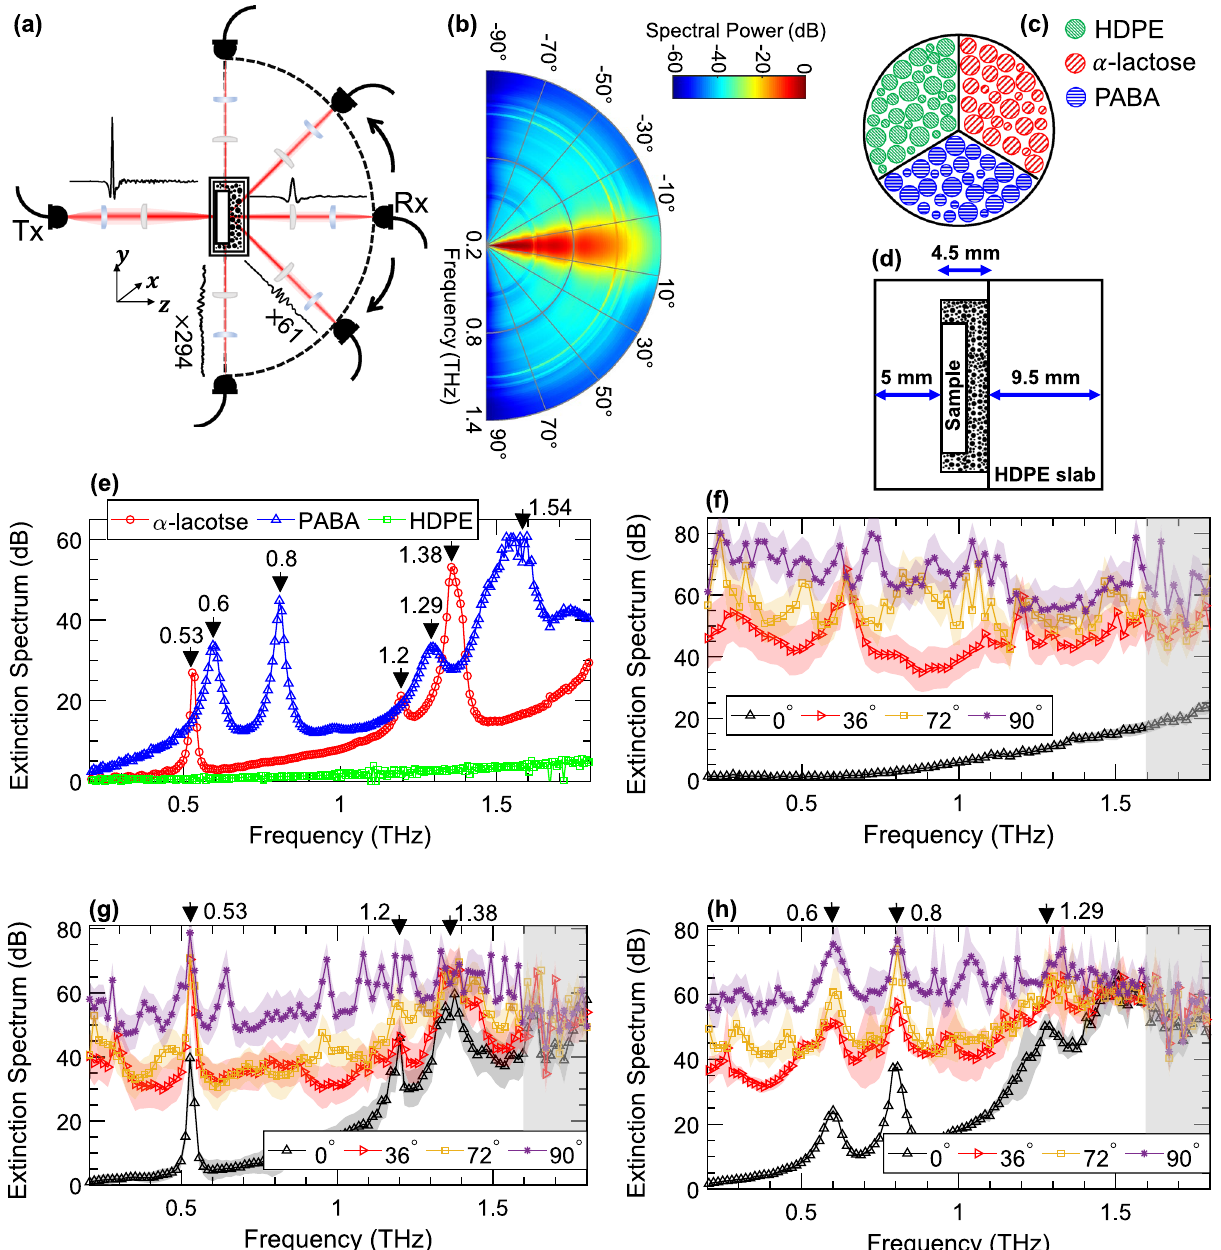
Figure 1. Diffuse-wave THz-TDS, ( a ) a schematic of the imaging apparatus designed for the measurement of the ballistic and diffuse THz fields, example THz-TDS signals, multiplied by the normalization factors for visualization purposes only, are given at different angles, ( b ) the angular distribution of the scattered THz spectral power (jet color map generated in MATLAB R2020b, https:// www. mathw orks. com/ produ cts/ matlab) measured through the sample embedded in the loosely-packed LDPE powders, showing a 60 dB decline from θ = 0 ◦ to 90°, ( c ) a schematic presentation of the imaging target outlining the regions covered by each chemical (i.e., HDPE (green circles), α -lactose (red circles), and PABA (blue circles)), ( d ) a schematic of the sample housing made from two HDPE slabs, a reservoir is made into one of the slabs to contain the sample pellet and the turbid medium surrounding it, ( e ) the extinction spectrum of the chemicals in the imaging target, measured without any scattering layers in the beam path, revealing the characteristic resonant frequencies, ( f - h ) the extinction spectra measured at four different detection angles including θ = 0 ◦ , 36°, 72°, and 90° from the pixels containing HDPE (the green circles in ( c )), α -lactose monohydrate (the red circles in ( c )), and PABA (blue circles in ( c )), respectively, each line in ( f - h ) shows the average extinction coefficient along its standard deviation over the pixels associated with each